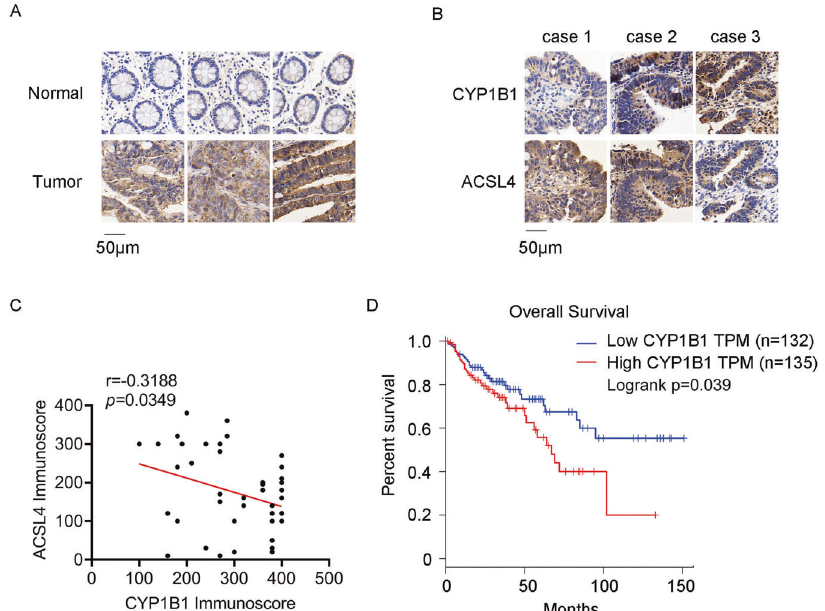
Fig. 5 The correlation between CYP1B1 and ACSL4. A IHC staining of CYP1B1 in CRC cancer tissues and adjacent normal tissues. B IHC staining of CYP1B1 and ACSL4 in CRC cancer tissues. C The correlation analysis between CYP1B1 and ACSL4 in CRC cancer tissues was explored using Pearson correlation analysis ( n = 44). D Overall survival was analyzed in COAD patients from the GEPIA database with low or high expression of CYP1B1 (de fi ned by RNA sequencing with group cut-off values of 50 and 50%).